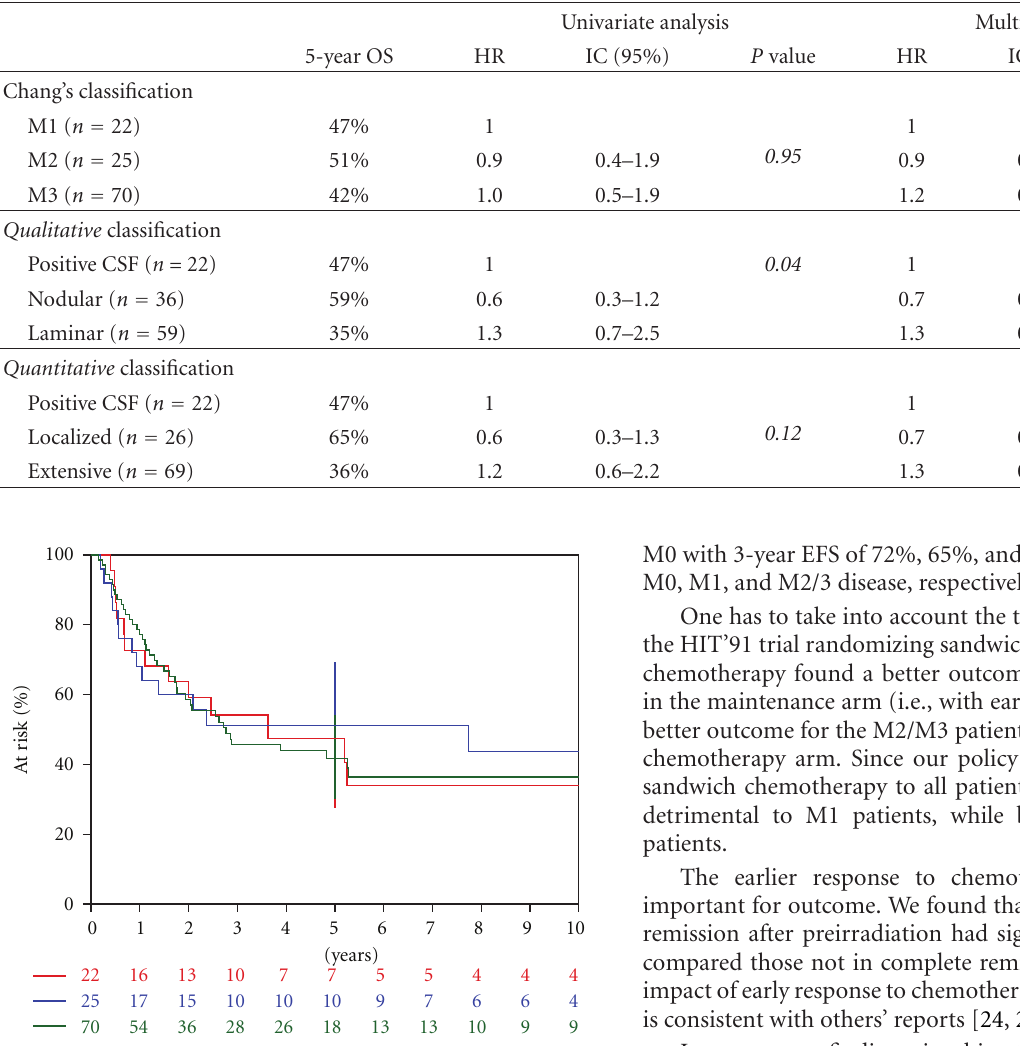
Table 3: Univariate and multivariate analysis of Overall Survival (OS).